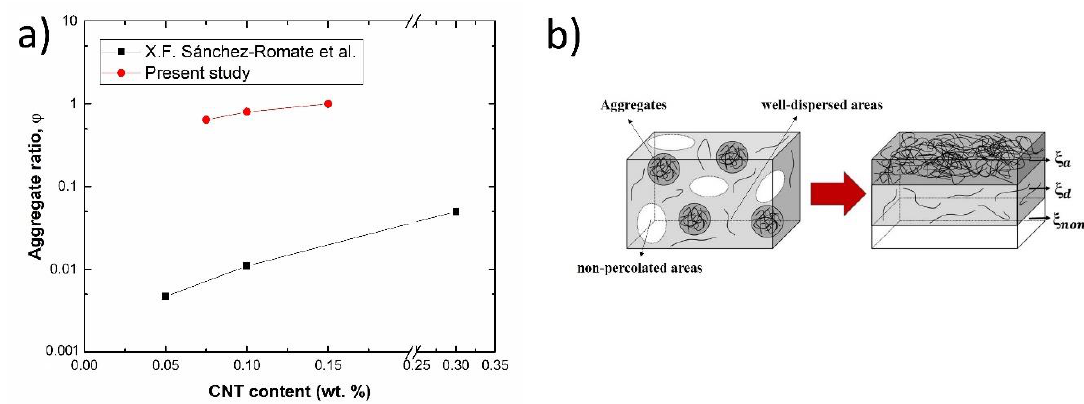
Figure 7. ( a ) Values of aggregate ratio as a function of CNT content and comparison to a previous study [31] and ( b ) schematics of block disposition for the electrical model indicating the aggregated, well-dispersed and non-percolated regions [31] (Reproduced with permission from X.F. Sánchez-Romate et al., Composites Science and Technology; published by Elsevier, 2019).